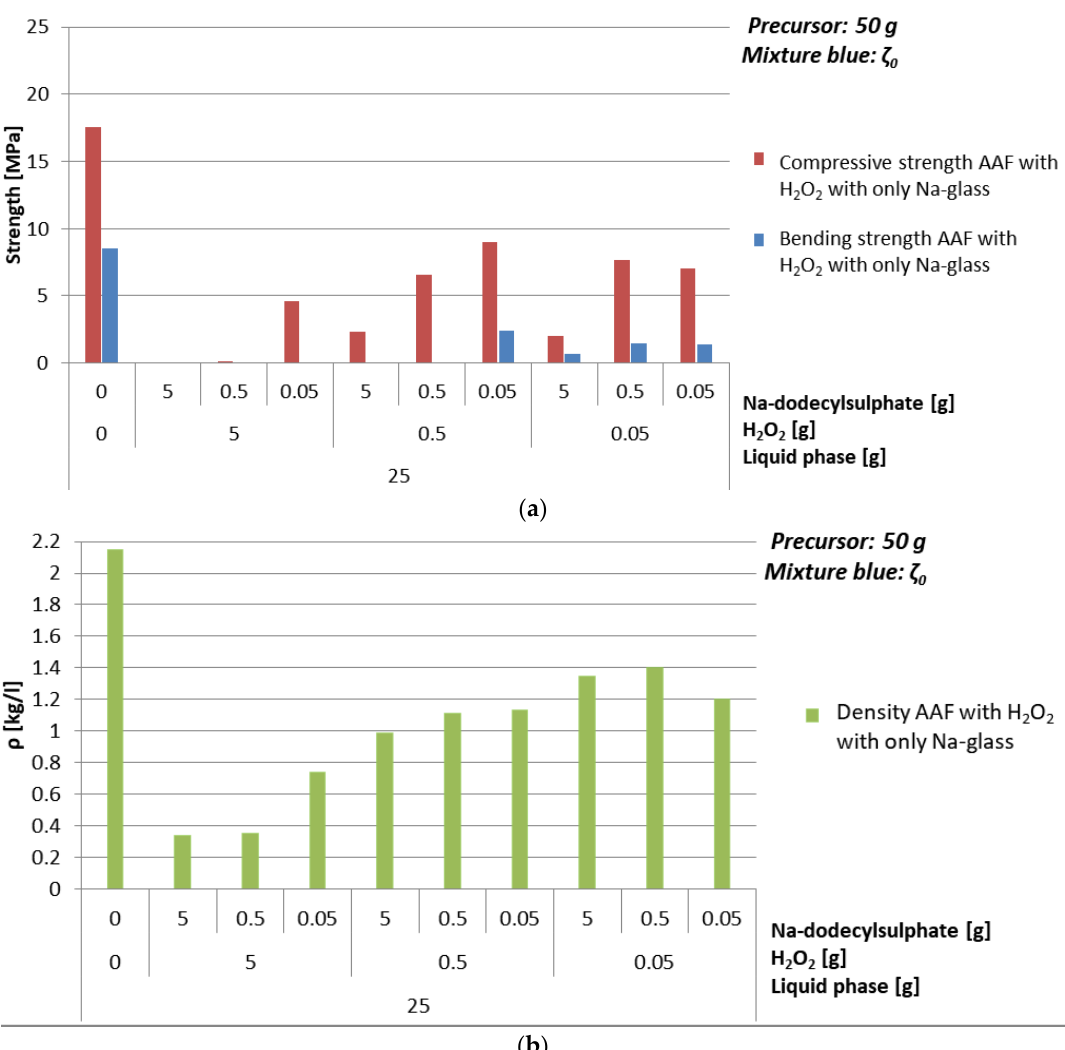
Figure 13. ( a ) Bending and compressive strength, ( b ) density of AAF, produced by H 2 O 2 using 25 g of mixture ζ 0 , i.e., combination of ingredients for AA resulting in literature’s highest compressive strength, cured on 70 °C for one day, measured one week after molding.